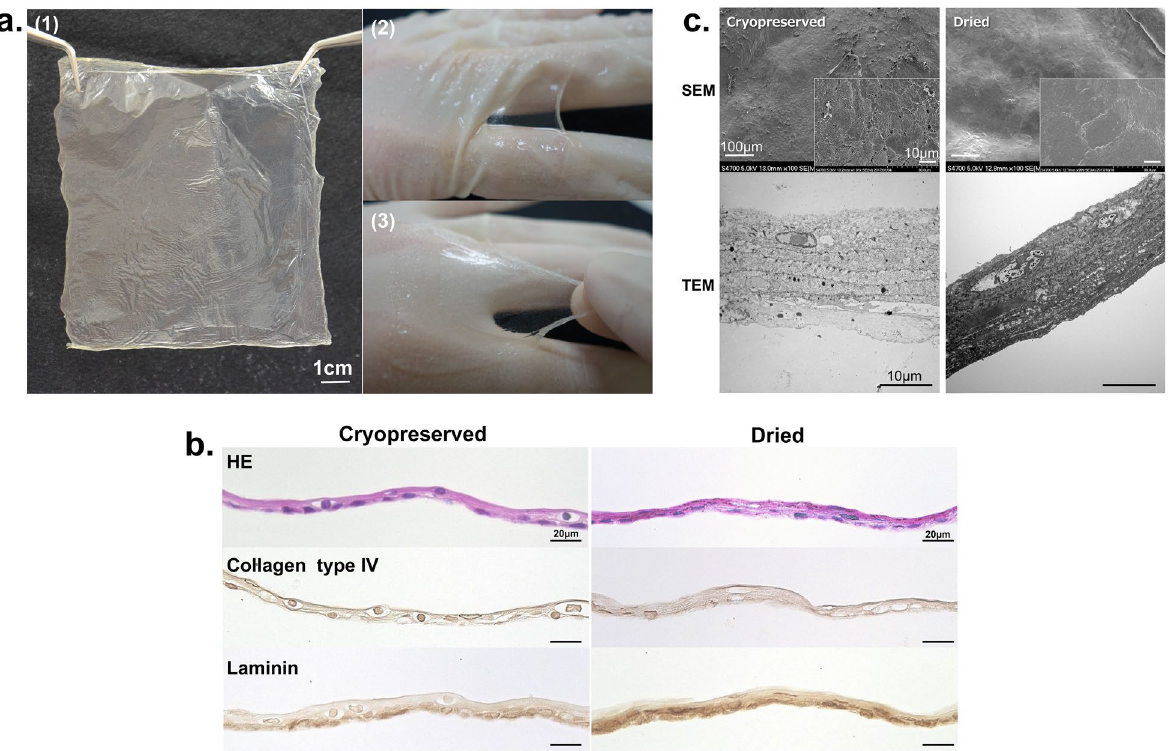
Figure 1. Morphological aspects of a dried CE. ( a ) Dried CE before hydration was cloudy, translucent, and fragile (1). The dried CE transformed into a transparent and flexible sheet with features similar to those of fresh CE sheets after rehydration (2,3). ( b ) Cryopreserved and dried CE sections stained with hematoxylin–eosin and anti-collagen type IV or anti-laminin antibodies. Both types of CEs exhibited similar morphological features, consisting of 4–5 layers of keratinocytes, including a monolayer of basal cells, constituting an undamaged membrane structure. The basal layers of both CEs were detected using immunostaining with an anti-laminin antibody, whereas the collagen type IV staining was not clear. ( c ) SEM and TEM images of cryopreserved and dried CEs. (TEM) Five to six layers of keratinocytes, including the monolayer of basal cell and desmosomal complexes at cell contact points, were observed in both CEs. (SEM) Both CEs appeared similar; the keratinocytes formed a smooth and regular membrane. No crack was observed on the membrane surface. CE, cultured epidermis; SEM, scanning electron microscopy; TEM, transmission electron